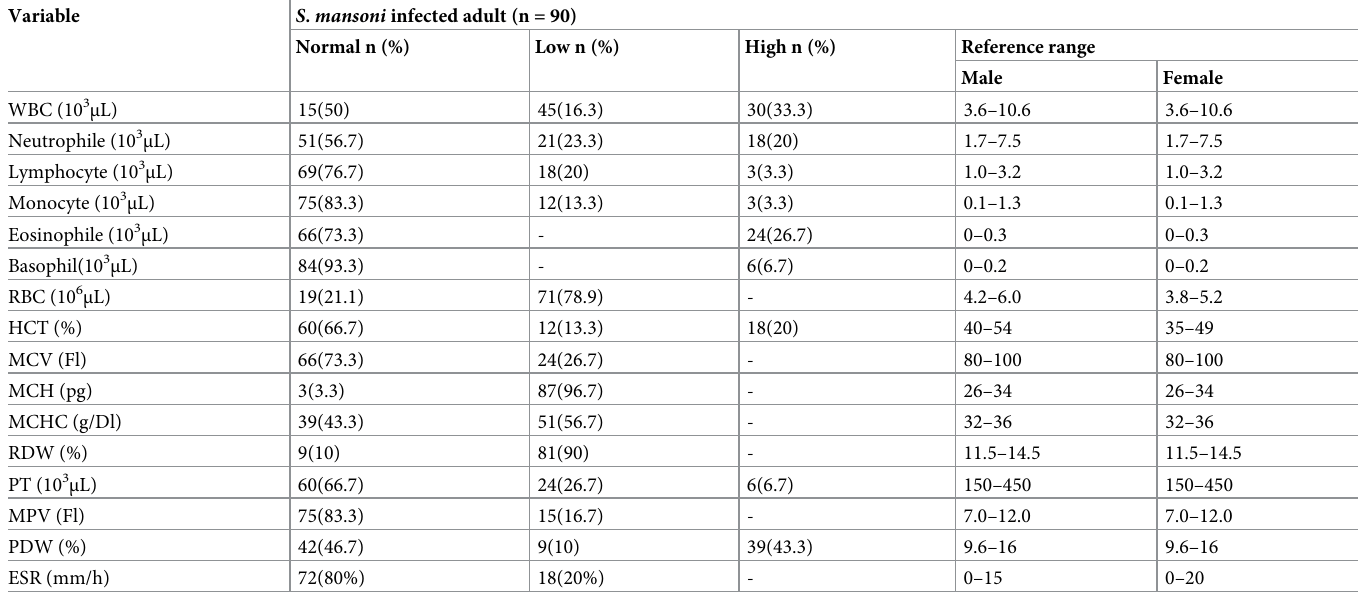
Table 2. Hematological profiles of S . mansoni infected study participants visiting Haik Primary Hospital, North-East Ethiopia, from February to April 2021. Variable